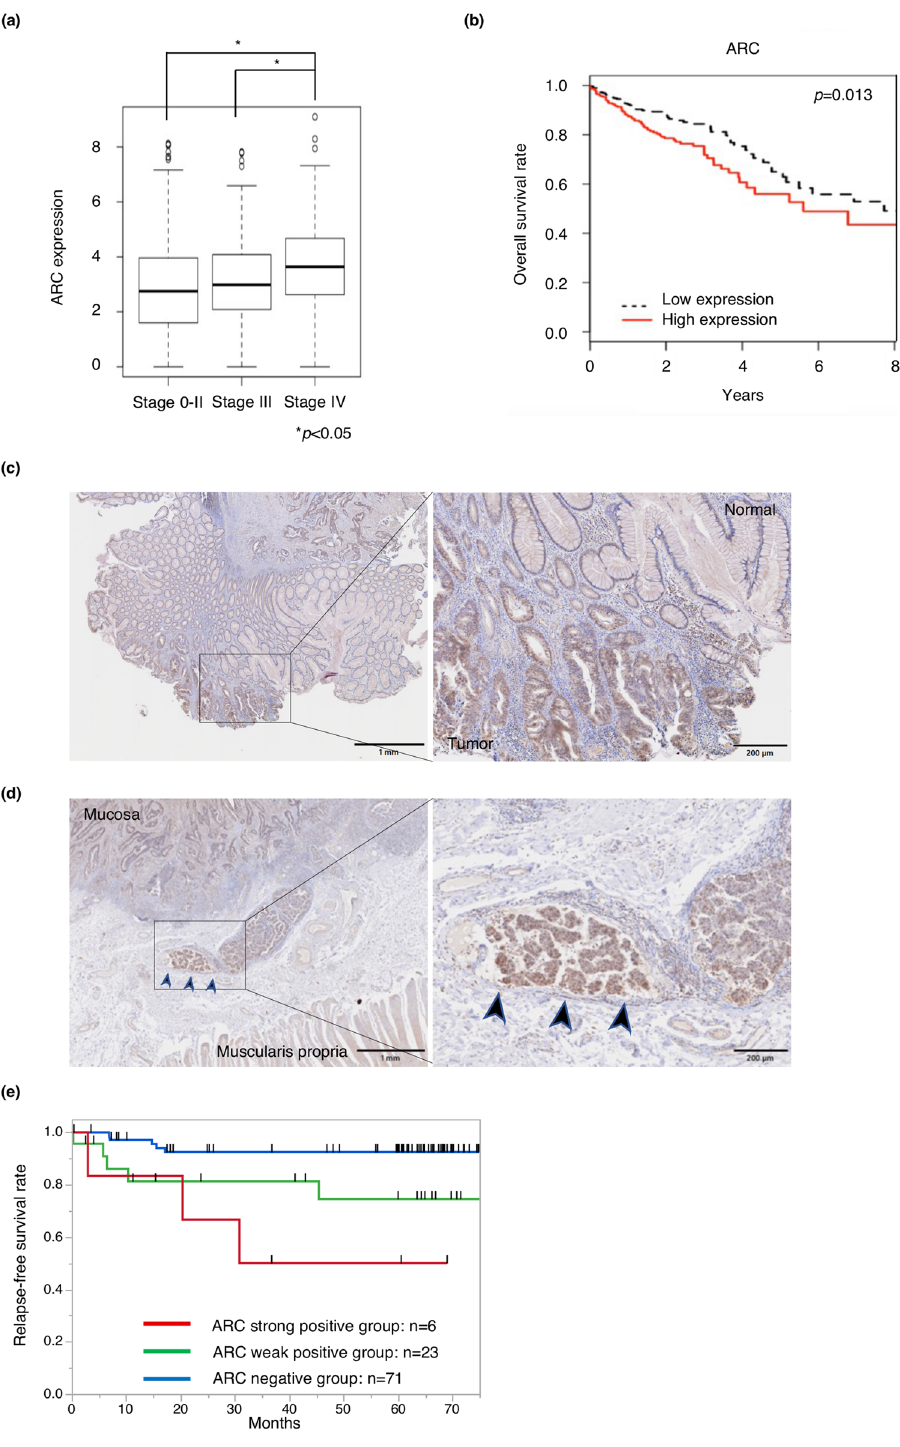
Figure 6. ARC expression in clinical samples in patients with CRC. ( a ) Box plot showing correlation between ARC expression and disease stage in patients with CRC in TCGA dataset. Stage 0–II: n = 271; stage III: n = 133; stage IV: n = 62. Within all samples, we analyzed samples which had complete TNM clinical stage information. Asterisks denote significant difference (* p < 0.05). ( b ) Kaplan–Meier curves for overall survival in patients with CRC according to expression of ARC ( p = 0.013). Patients are divided into two groups by the median. These data were obtained from Broad GDAC Firehose colorectal adenocarcinoma (COADREAD) dataset (https:// gdac. broad insti tute. org/) (n = 615). ( c ) IHC of ARC in tumor and normal tissue in a specimen of CRC. Scale bars indicate 1 mm (left) and 200 µm (right). ( d ) IHC of ARC in the deepest parts of tumor in a specimen of CRC. Scale bars indicate 1 mm (left) and 200 µm (right). ( e ) Kaplan–Meier curves for relapse-free survival in patients with CRC according to ARC expression. Patients are divided into three groups by the intensity of ARC expression in IHC (n = 100). CRC colorectal cancer, TCGA The Cancer Genome Atlas, IHC immunohistochemical